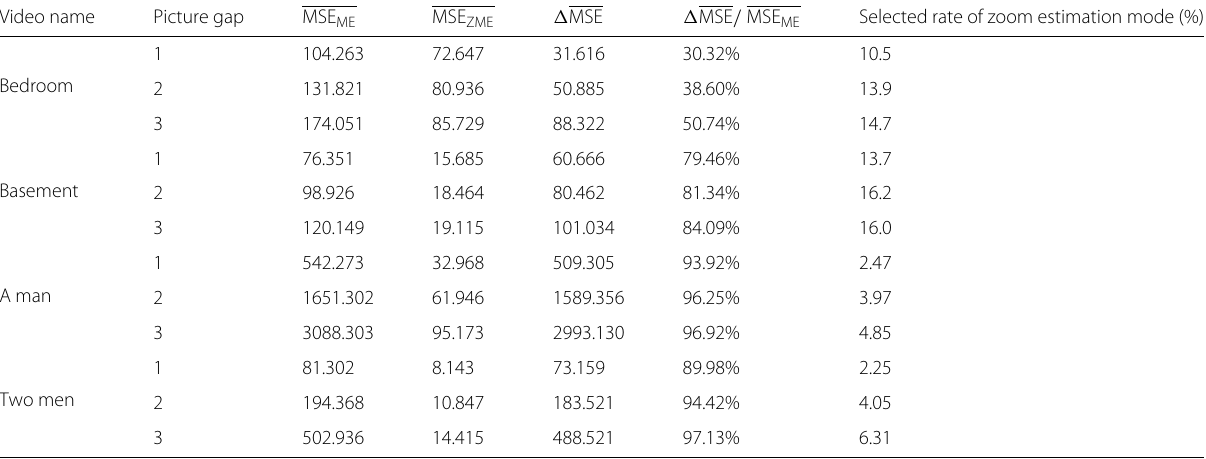
Table 3 Averages of MSEs in depth video according to frame gap in 8 × 8 block size